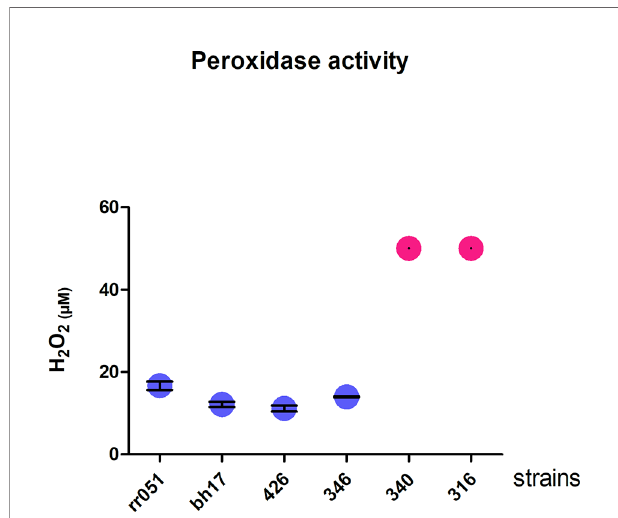
FIGURE 6 | Peroxidase activity. Degradation of hydrogen peroxide by cell lysates of promastigote forms of different strains of Leishmania braziliensis . In blue, LbTL group; in pink, LbAL group. These experiments were performed twice in triplicate. Measurements from the atypical group exceeded the test capacity (50µM) and, thus, no standard deviation can be